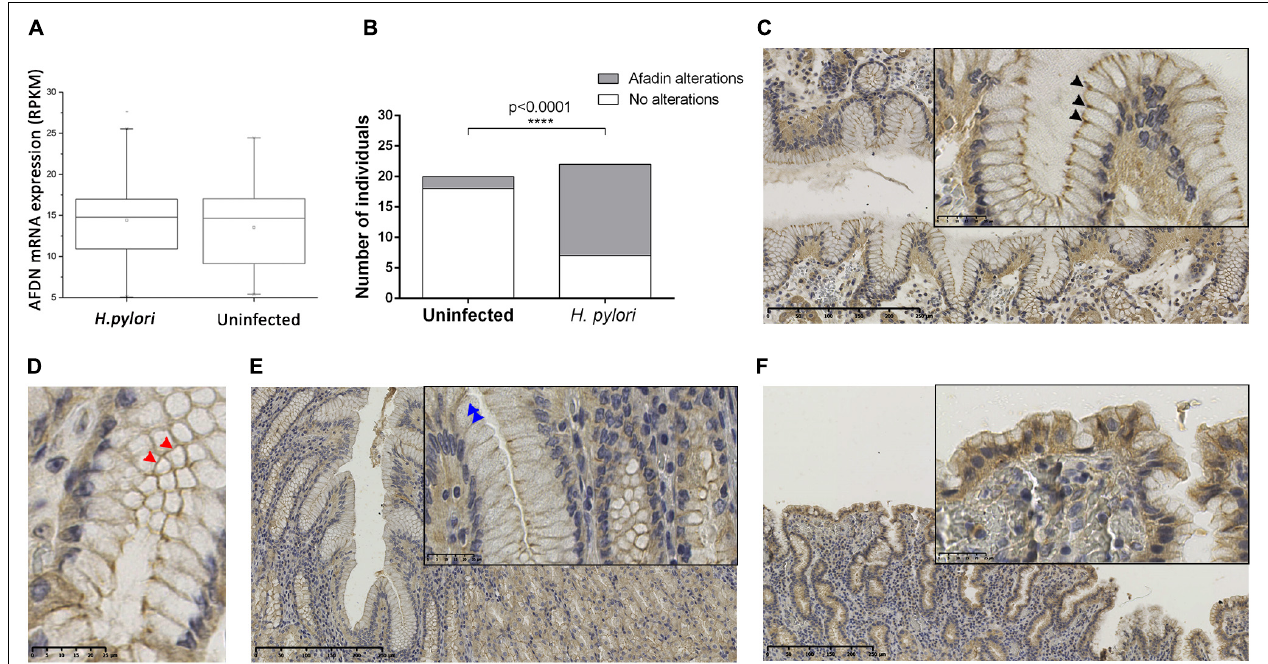
FIGURE 6 | H. pylori infection affects the expression and localization of the Afadin protein in the human gastric mucosa. (A) AFDN gene expression in the stomach of 181 (114 uninfected and 67 H. pylori -infected) individuals without disease, retrieved from the GTEx database. RPKM, reads per kilobase million. Significance was evaluated with Kruskal–Wallis statistics. (B–F) Immunohistochemical detection of Afadin in paraffin-embedded sections of the gastric mucosa of individuals uninfected ( n = 20) or infected with H. pylori ( n = 22). (B) Graphical representation of Afadin alterations in the two biological groups. Statistical significance was determined with the Fisher’s exact test. Representative micrographs of Afadin staining in an uninfected individual, showing a strong intensity at the apicolateral epithelial cell–cell contacts (black arrowheads) (C) , and a belt-like pattern (red arrowheads) (D) in longitudinal and cross sections, respectively, and in H. pylori -infected individuals, presenting decreased intensity/loss of membrane staining at the cell–cell contacts (blue arrowheads) (E) or showing cytoplasmic staining in areas of epithelial tufting (F) .